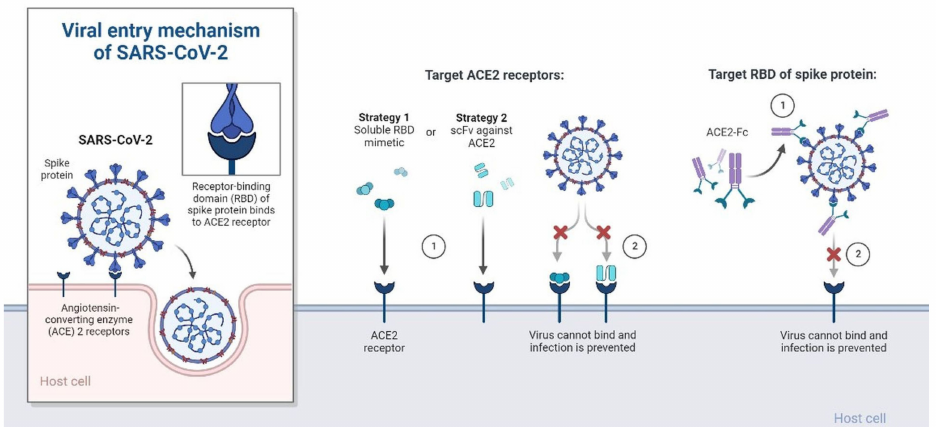
Figure 23. Therapeutic strategies to treat SARS-CoV-2 infection based on virus-cell interaction. Host- targeted strategies include RBD mimetics and antibody fragments, such as scFv. Virally targeted strategies include antibodies or antibody fragments, such as Fc. In both cases, the ACE2-RBD interaction is inhibited, preventing infection. The template can be either used as is or adapted to demonstrate other virus-cell